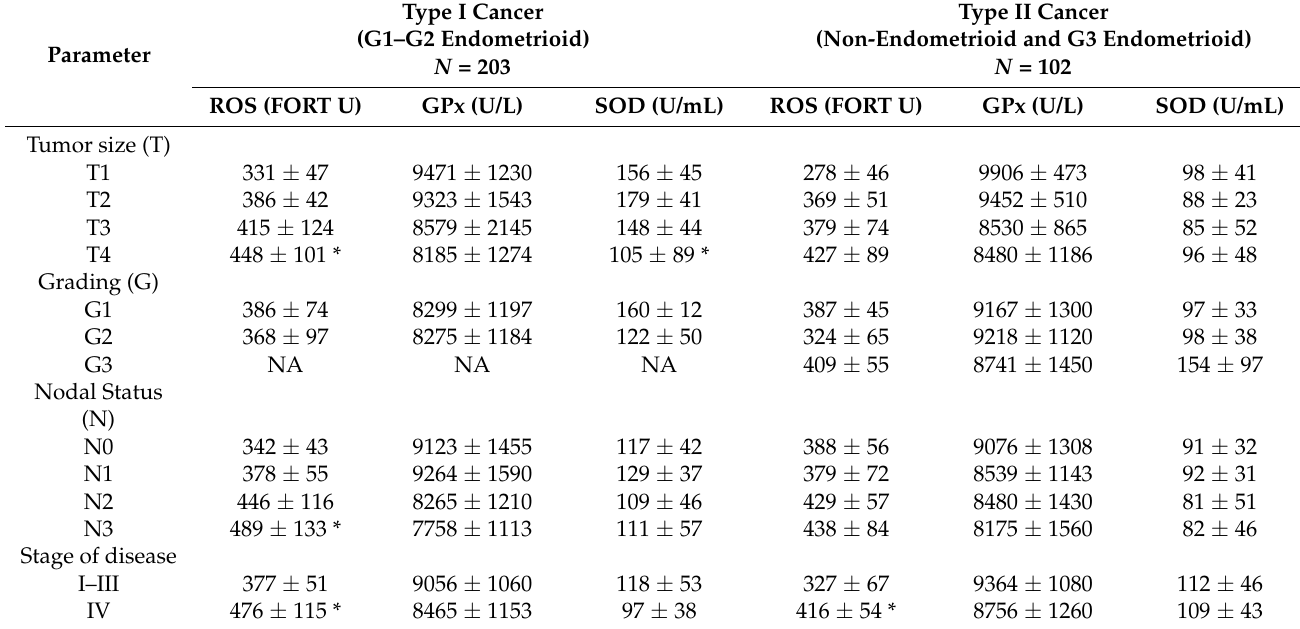
Table 5. Evaluation of oxidative stress parameters according to endometrial cancer